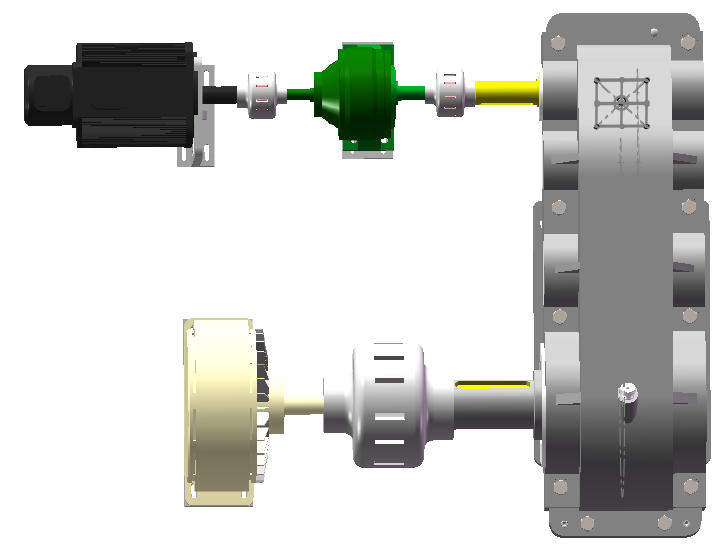
Figure 6. Gear test bench model.